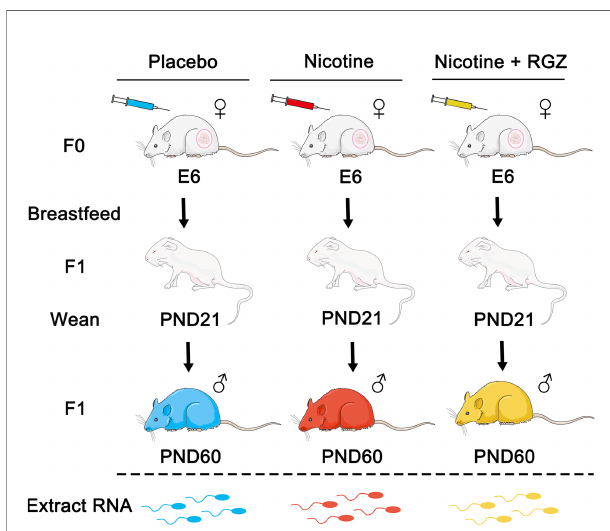
FIGURE 1 | The perinatal nicotine exposure rat model used in the present study. Dams (F0) received either placebo (saline), nicotine (1 mg/kg, subcutaneously), or nicotine (1 mg/kg, subcutaneously) plus rosiglitazone (RGZ) (3 mg/kg, intraperitoneally) once daily from embryonic day 6 (E6) of gestation to postnatal day 21 (PND21). The F1 pups were allowed to breastfeed ad libitum. At PND21, the F1s were weaned and maintained in separate cages. Pure sperm cells of F1 male rats were collected at PND60 and sperm RNA was extracted and used for RNA-seq